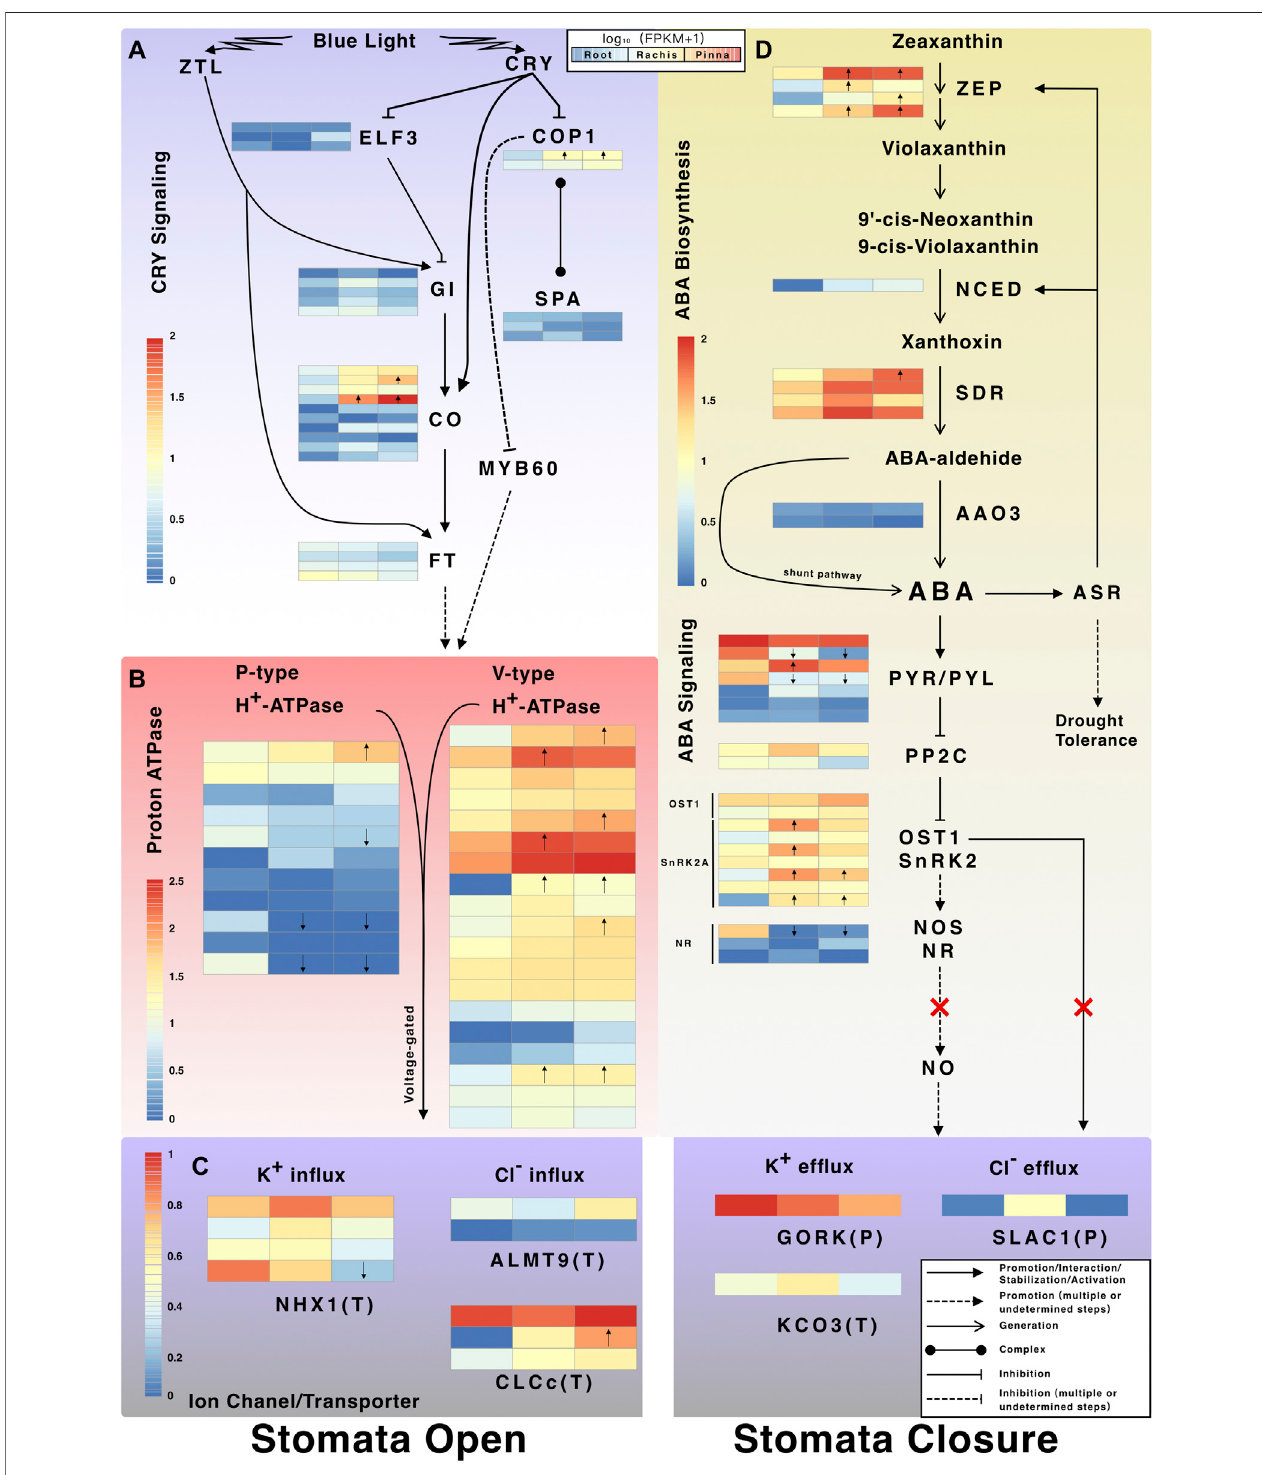
FIGURE 7 | The CRY signaling pathway and ABA biosynthesis and signaling pathway. (A) Expression pro fi les of CRY-regulated stomatal opening-related genes. (B) Expression pro fi les of proton atpase genes; (C) Expression pro fi les of ion channel and transporter genes involved in stomatal movement. The P in parentheses indicates the ion channel/transporter located at the plasma membrane. The T in parentheses indicates the ion channel/transporter located at tonoplast. (D) Expression pro fi les of genes in ABA biosynthesis and signal transduction pathway. Arrows inside the heatmap indicate the up/downregulated genes in rachis/pinna versus